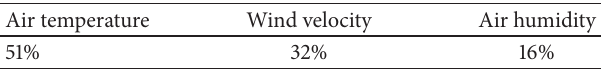
Table 4: The spatial distribution of relative contribution ratios of climate factors to air drying force.